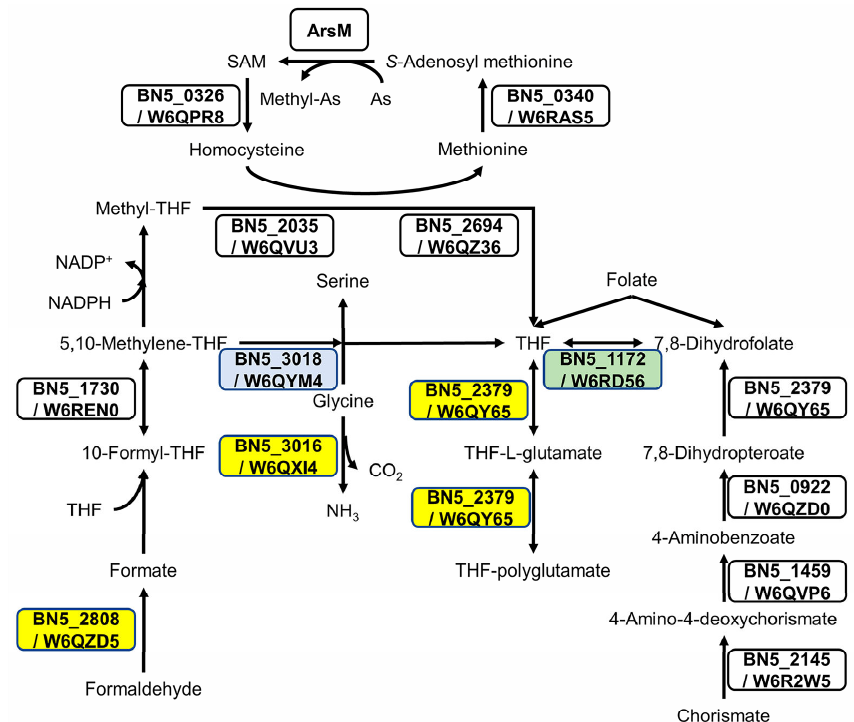
Figure 2. The effect of arsenite on proteins involved in tetrahydrofolate (THF) metabolism. Folate biosynthesis (ppse00790), biosynthesis of cofactors (ppse01240), and carbon metabolism (ppse01200) from KEGG were analyzed to build the metabolic pathways. Proteins W6QZD5 ( S -formylglutathione hydrolase encoded by BN5_2808), W6QXI4 (glycine cleavage system H protein encoded by BN5_3016), and W6QY65 (dihydrofolate/folylpolyglutamate synthase encoded by BN5_2379), marked in yellow boxes, were induced by As(III) when ammonium was used as N-source. The protein W6QYM4 (serine methylase encoded by BN5_3018), shown in a blue box, was induced by As(III) with cyanide as N-source. The protein W6RD56 (dihydrofolate reductase encoded by BN5_1172), boxed in green, was identified only in cyanide, with or without